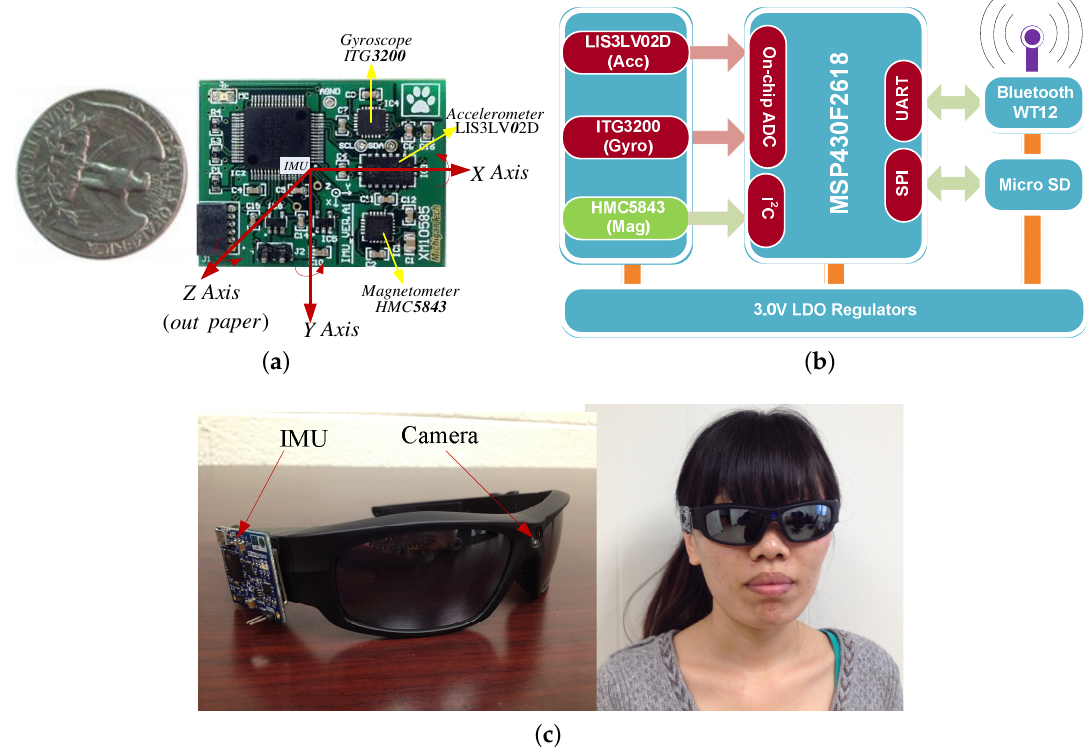
Figure 4. Prototype of MARG sensor and wearable vIMU system. ( a ) the developed MARG sensor; ( b ) hardware configuration of MARG sensor; ( c ) the wearable vIMU